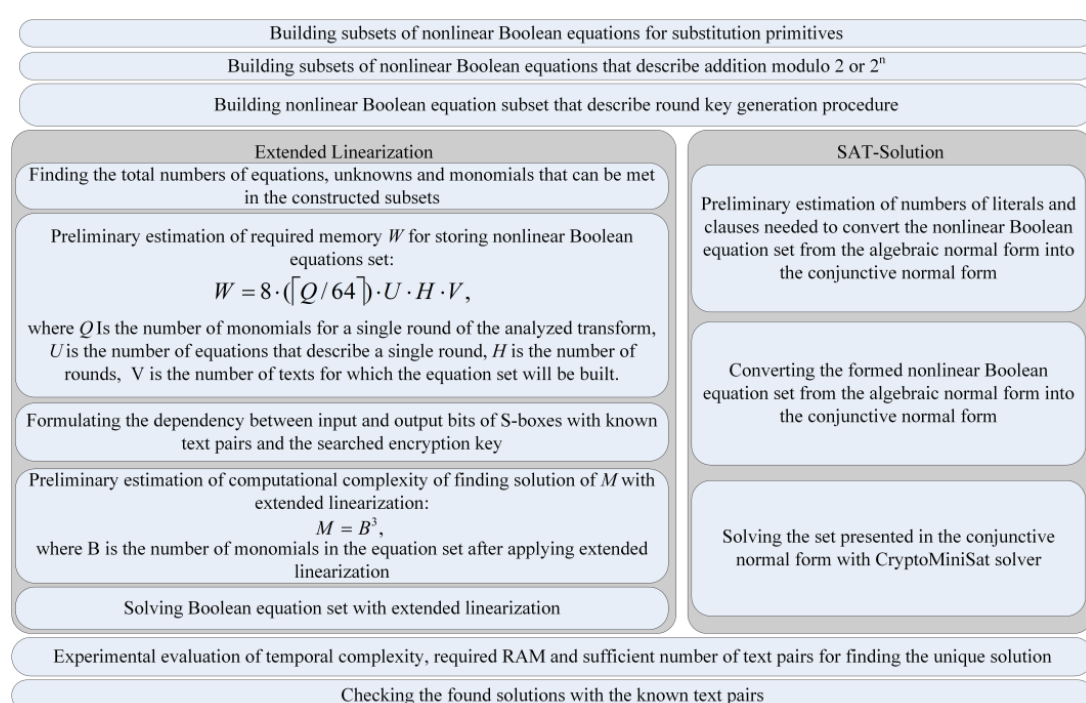
Figure 4. Security assessment methodology approach.